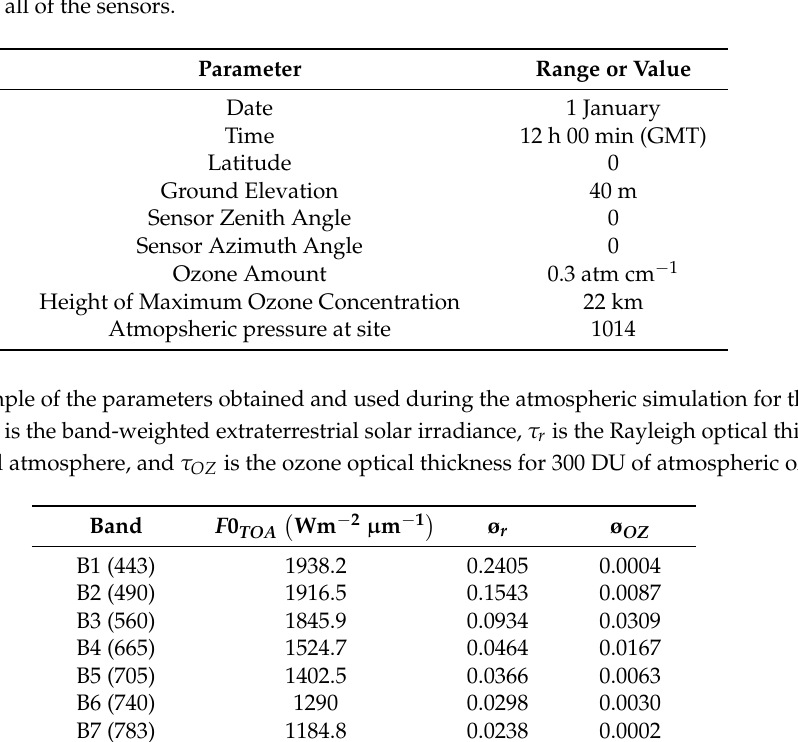
Table 5. Parameters used during the conversion of the TOA irradiance solar spectrum to surface irradiance for all of the sensors.